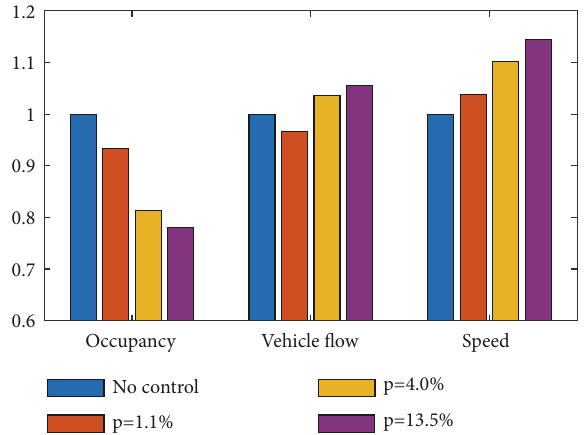
Figure 13: Mainline performance indicators under different